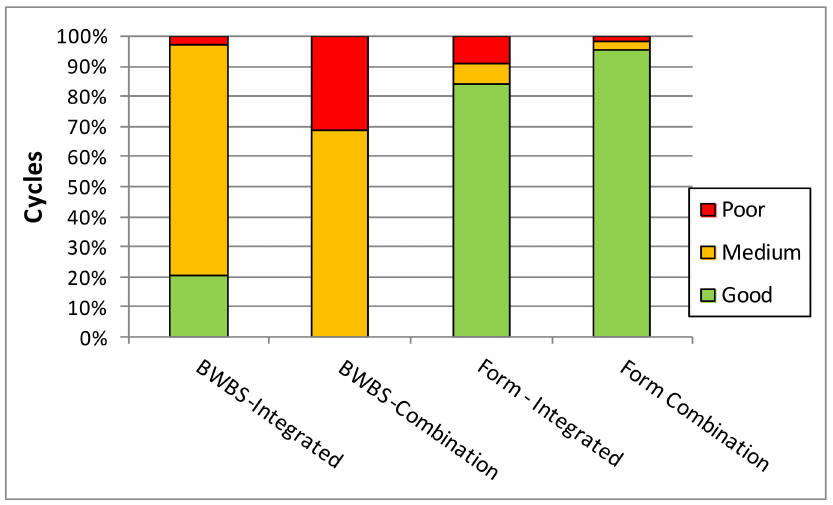
Figure 2. Breakdown of tree characteristics by quality class and machine